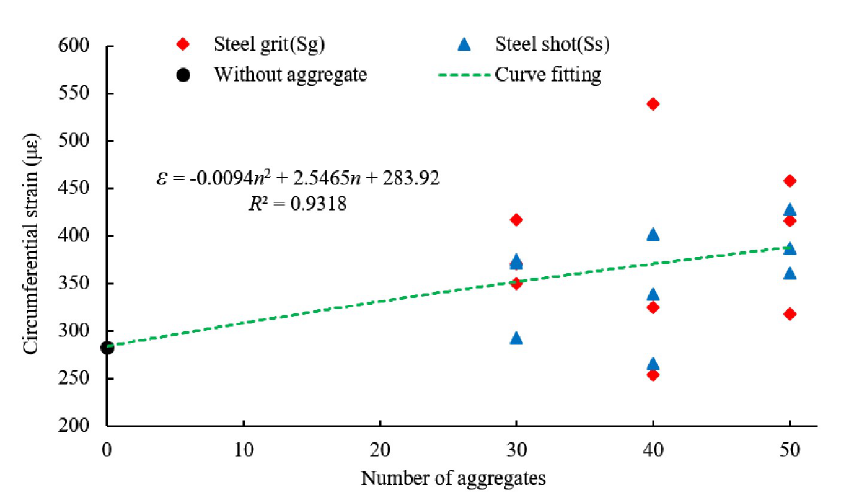
Fig 17. Scatter plot of circumferential strain and fitting curve of different aggregate quantities.